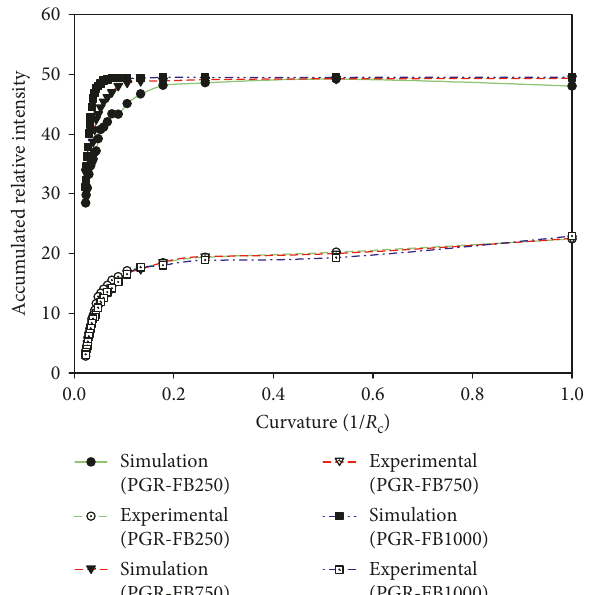
Figure 12: Experimental and theoretical end-tip-illumination measurement for one-sided POF using large-step